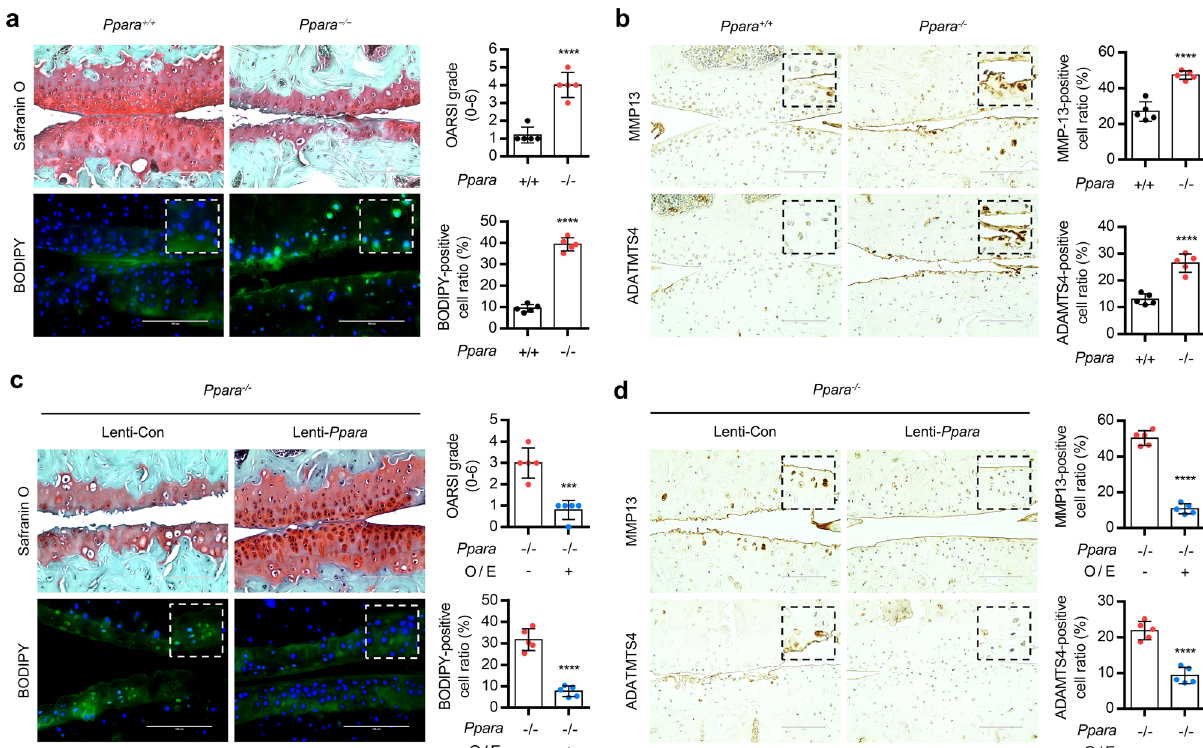
Fig. 2 PPAR α de fi ciency is involved in OA pathogenesis. a Safranin O or BODIPY staining in the cartilage of Ppara + / + and Ppara − / − mice at 8 weeks post surgery. The degree of cartilage degradation is quanti fi ed according to OARSI grade and BODIPY-positive cells were indicated by bar – dot plot ( n = 5), P < 0.0001. Scale bar, 100 μ m. b Immunohistochemistry of MMP13 and ADAMTS4 in Ppara + / + and Ppara − / − mice at 8 weeks post surgery. Scale bar, 100 μ m. Positive cells of MMP13 and ADAMTS4 were indicated by bar – dot plot ( n = 5), P < 0.0001. c Safranin O and BODIPY staining in the cartilage of DMM-induced Ppara + / + and Ppara − / − treated with Lenti − Ppara . Scale bar, 200 μ m. The OARSI grade, the thickness of the tibia, and BODIPY-positive cells are indicated by graph ( n = 5), P = 0.0004 for OARSI grade, P < 0.0001 for BODIPY. d , Immunostaining of MMP13 and ADAMTS4 in the cartilage of DMM-induced Ppara + / + and Ppara − / − treated with Lenti − Ppara . Positive cells of MMP13 and ADAMTS4 were indicated by bar – dot plot ( n = 5), P < 0.0001. Values are means± SD. Unpaired Student ’ s t test ( a – d ) was used for statistical analysis. *** P < 0.001; **** P <